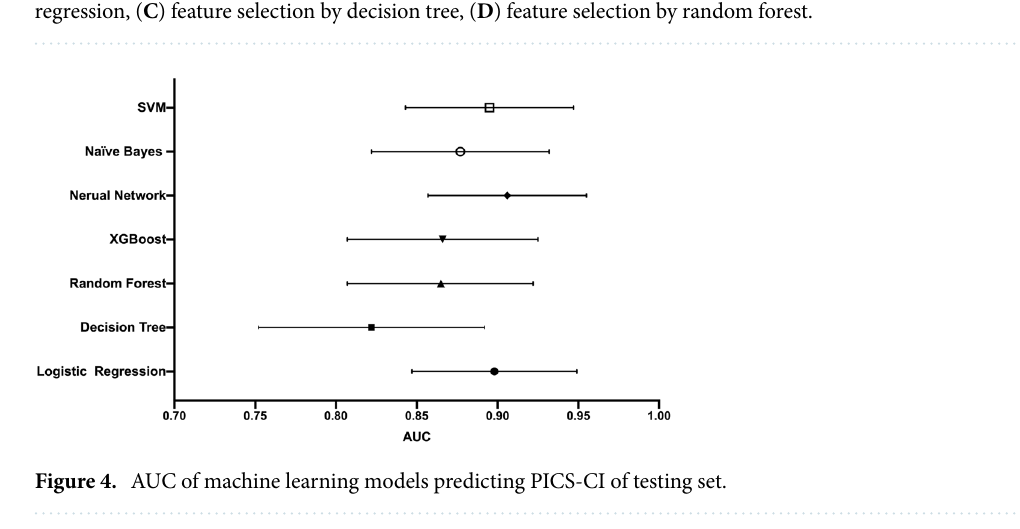
Figure 3. Importance of the candidate features. ( A ) Feature selection by LASSO, ( B ) feature selection by logistic regression, ( C ) feature selection by decision tree, ( D ) feature selection by random forest.